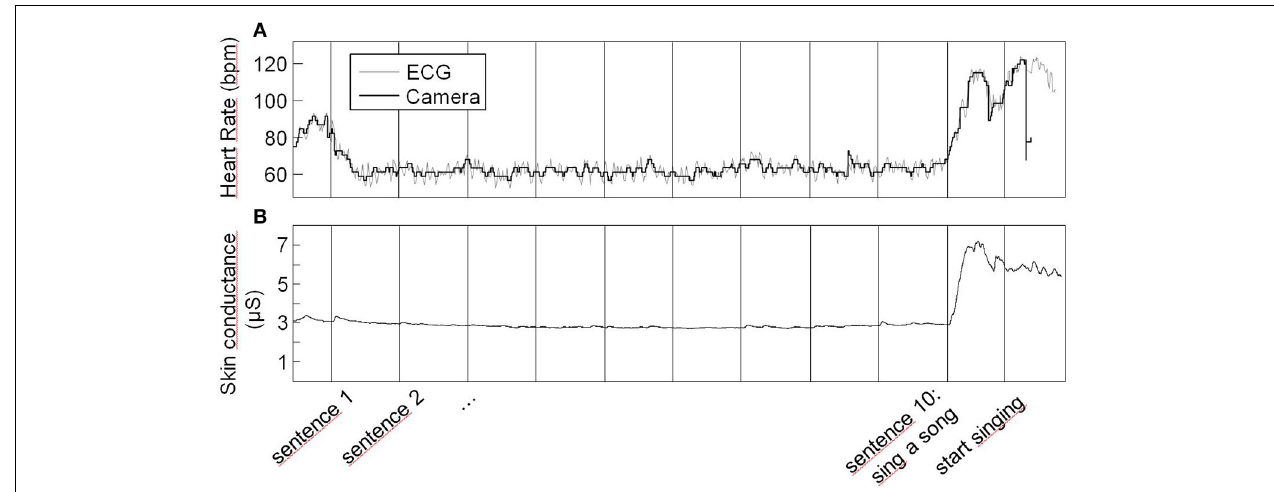
FIGURE 1 | Heart rate (A) and skin conductance (B) of an example participant across the whole experiment. Vertical lines indicate the sentence onsets except for the very last one that corresponds to